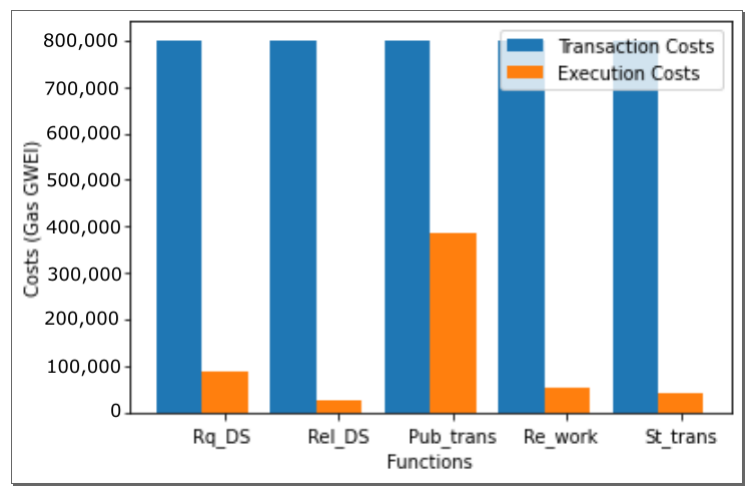
Figure 11. Transactions published and stored on blockchain (where Rq_DS = request dataset, Rel_DS = release dataset, Pub_trans = public transaction, Re_work = reuse work, and St_trans = store